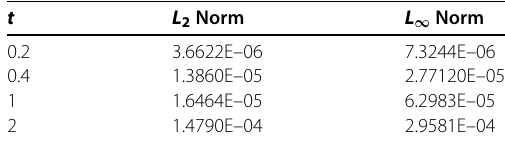
Table 4 Error norms for Example 1 when h = 1 (cid:2) t = 1 , γ = 1.5 at different time 120